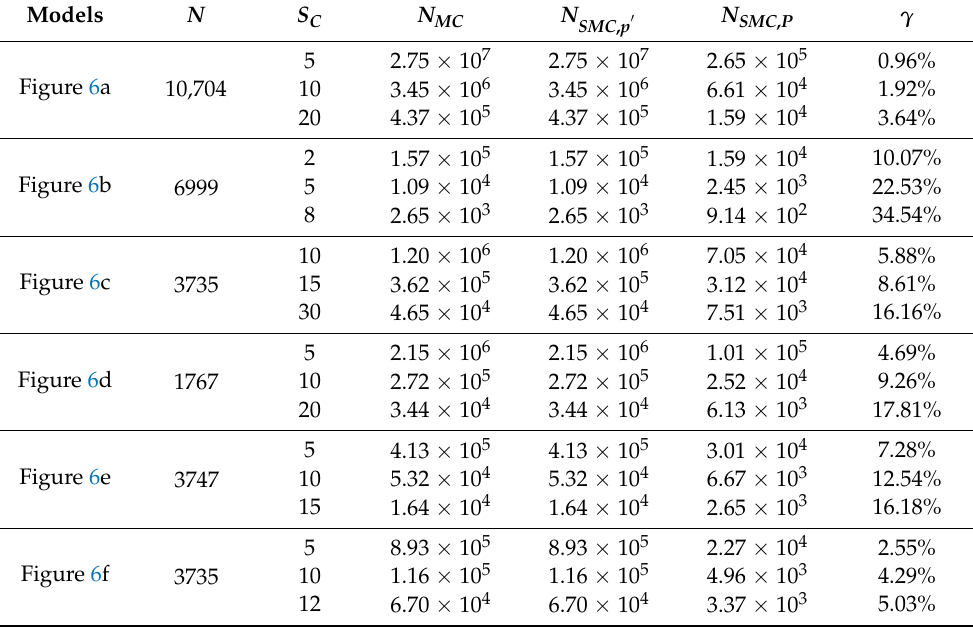
Table 3. Number of evaluation points about the reconstructed models in Figure